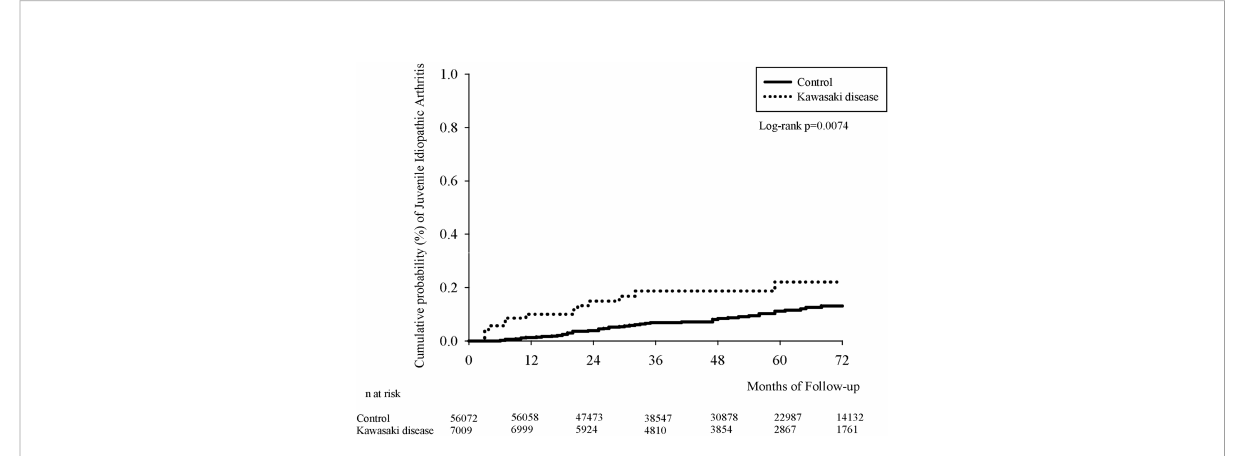
FIGURE 2 Kaplan – Meier curve of cumulative incidence proportion of JIA in the Kawasaki-disease and non-Kawasaki-disease groups.